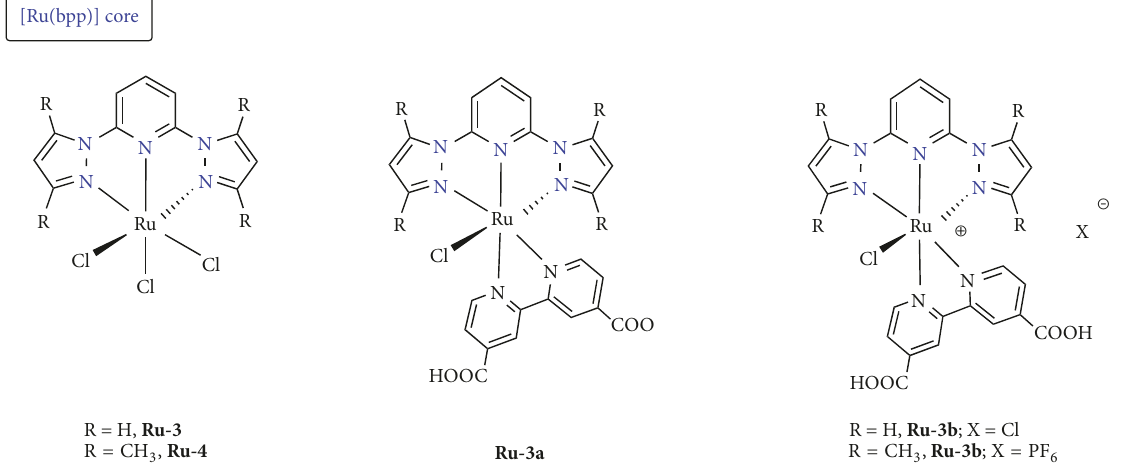
Figure 10: Molecular structures of Ru(III)/(II) inhibitors with tridentate ligands.